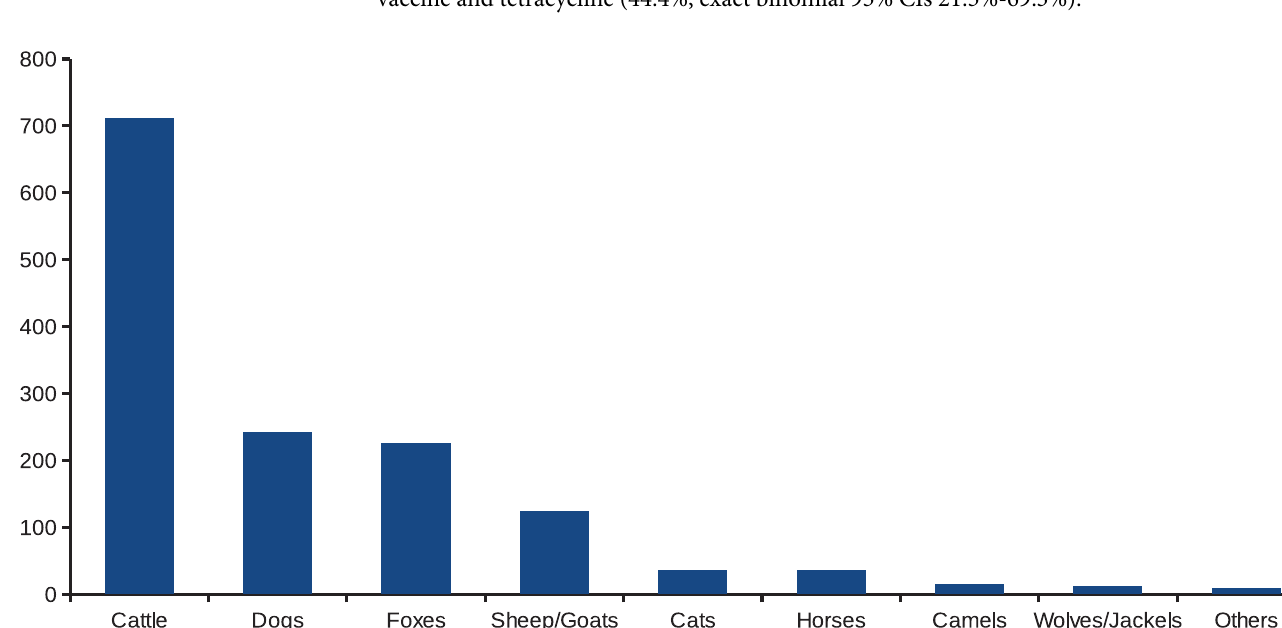
Fig 1. Numbers of confirmed rabies cases in animals by species affected between 2003 and 2015 in Kazakhstan.